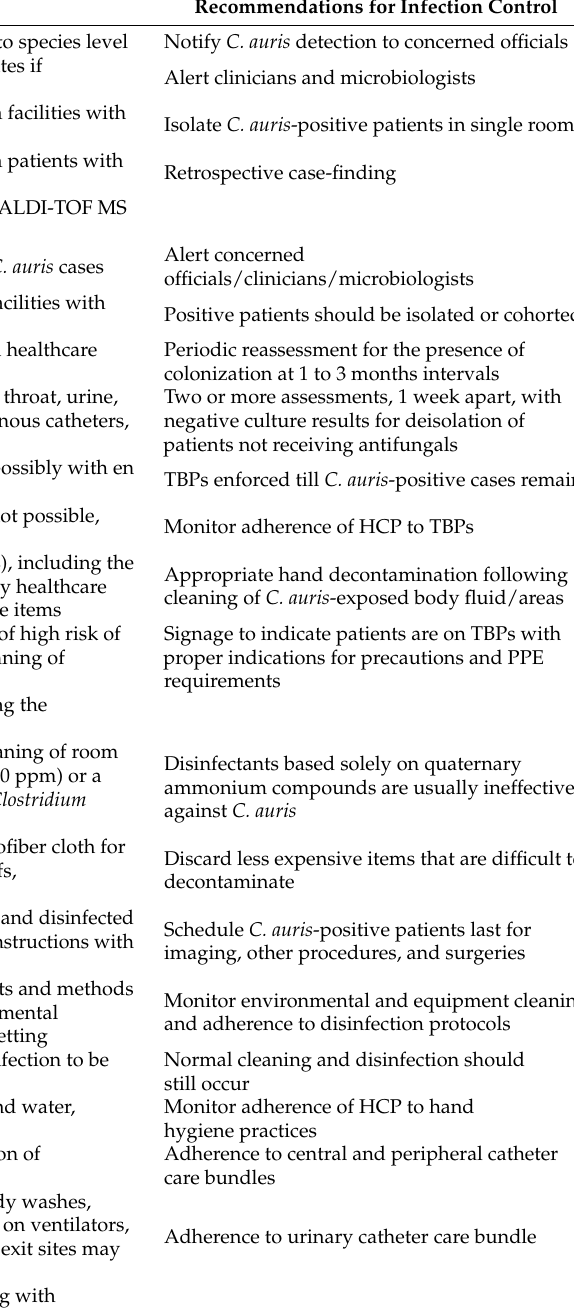
Table 4. Key infection prevention and control steps and recommendations for C. auris single case and/or during outbreaks. Intervention